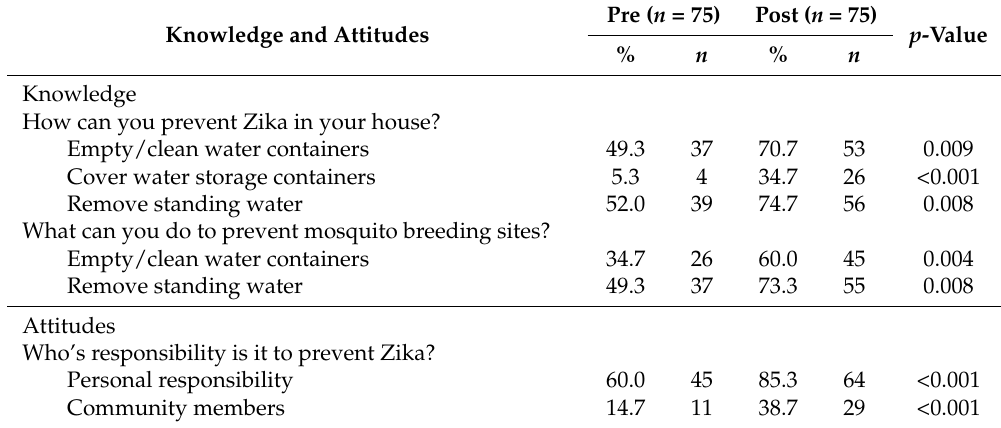
Table 2. Respondent’s knowledge and attitudes regarding Zika prevention and vector control practices at pre and post-assessments.